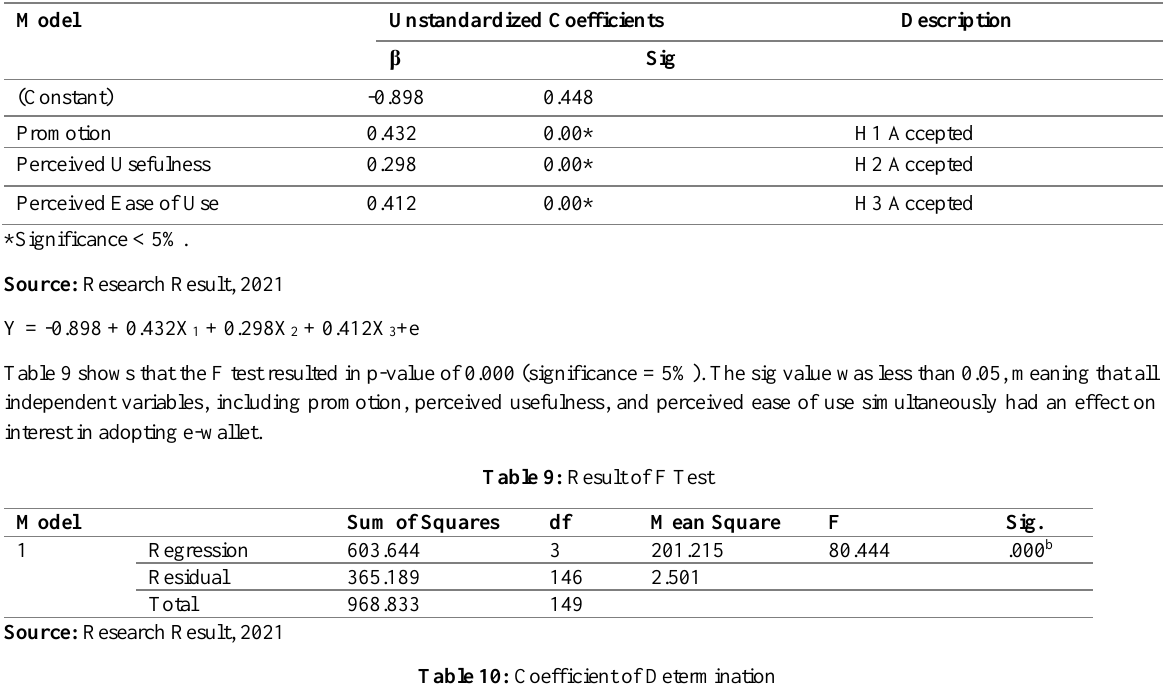
Table 8: Results Of Multiple Linear Regression